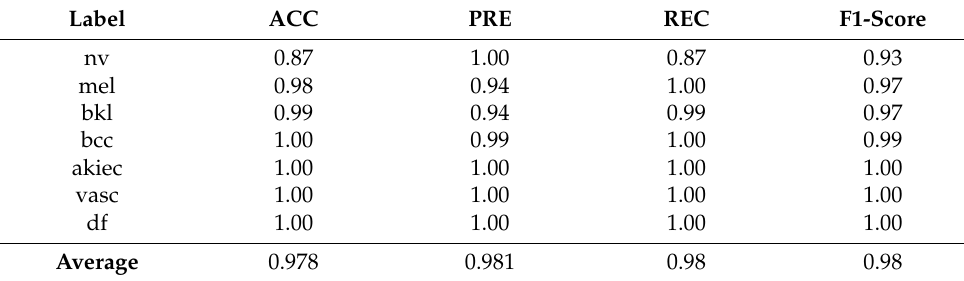
Table 5. Accuracy, precision, recall, and f1-score with each fold of data calculated using k-fold cross-validation